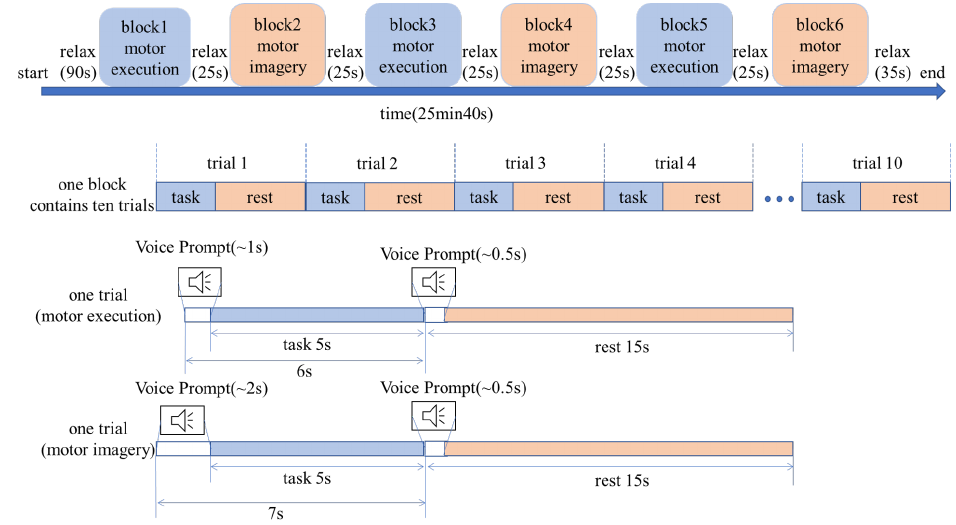
Figure 1. Experiment design (RPS motor imagery